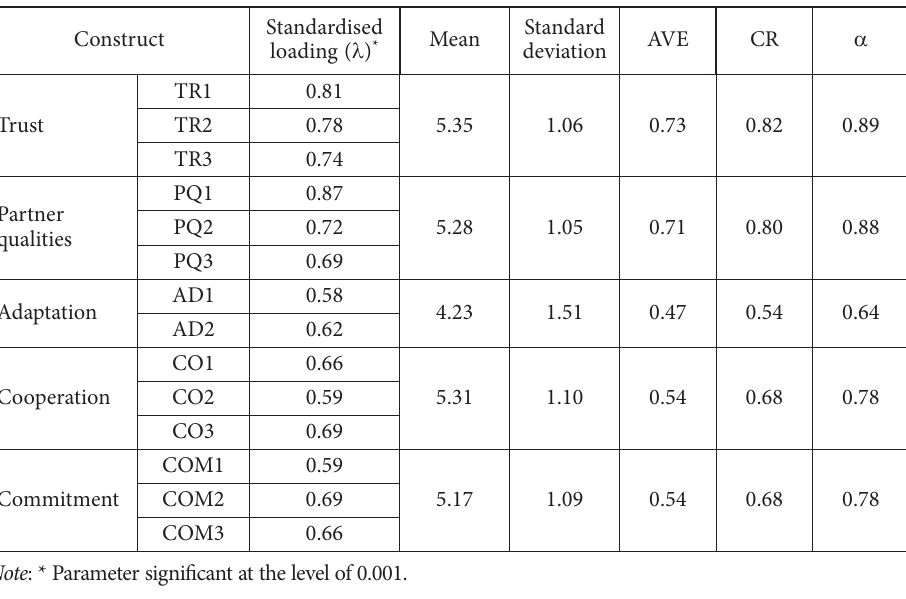
Table 2. Confirmatory factor analysis results